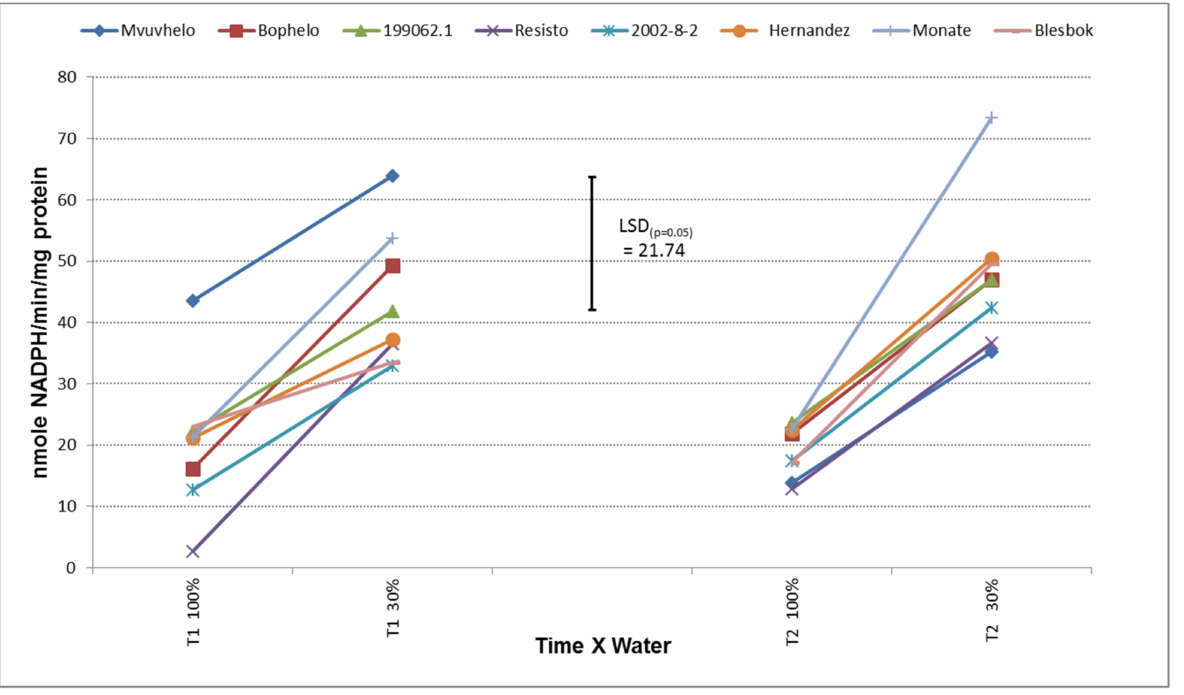
= 0.124; T1 = 60 days ( p = 0.05)